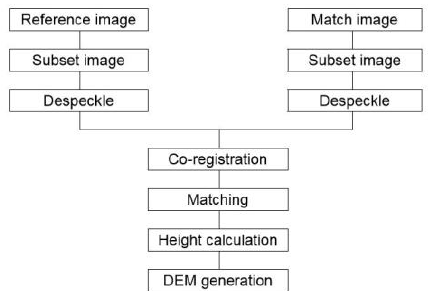
Figure 3. Radargrammetry processing (Yu et al, 2010) Radargrammetry technique derived from photogrammetry and based on the stereoscopic principle. Interferometry technique based on the phase differences between identical imaged points in two SAR images.